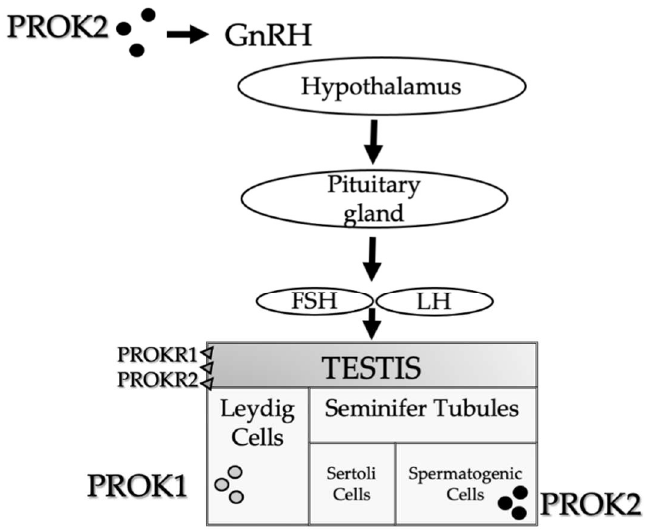
Figure 1. PROKs schematic representation in the male reproductive system. PROK1 is mainly expressed in steroidogenic organs, particularly in the Leydig cells. PROK2 is primarily expressed in the central nervous system, which influences the olfactory bulb development and GnRH neural migration, and in non-steroidogenic cells of the testes. PROK2 expression is limited to the seminiferous tubules in the primary spermatocytes. In the testes, both receptors (PROKR1 and PROKR2) are expressed in endothelial cells in the interstitial tissue.